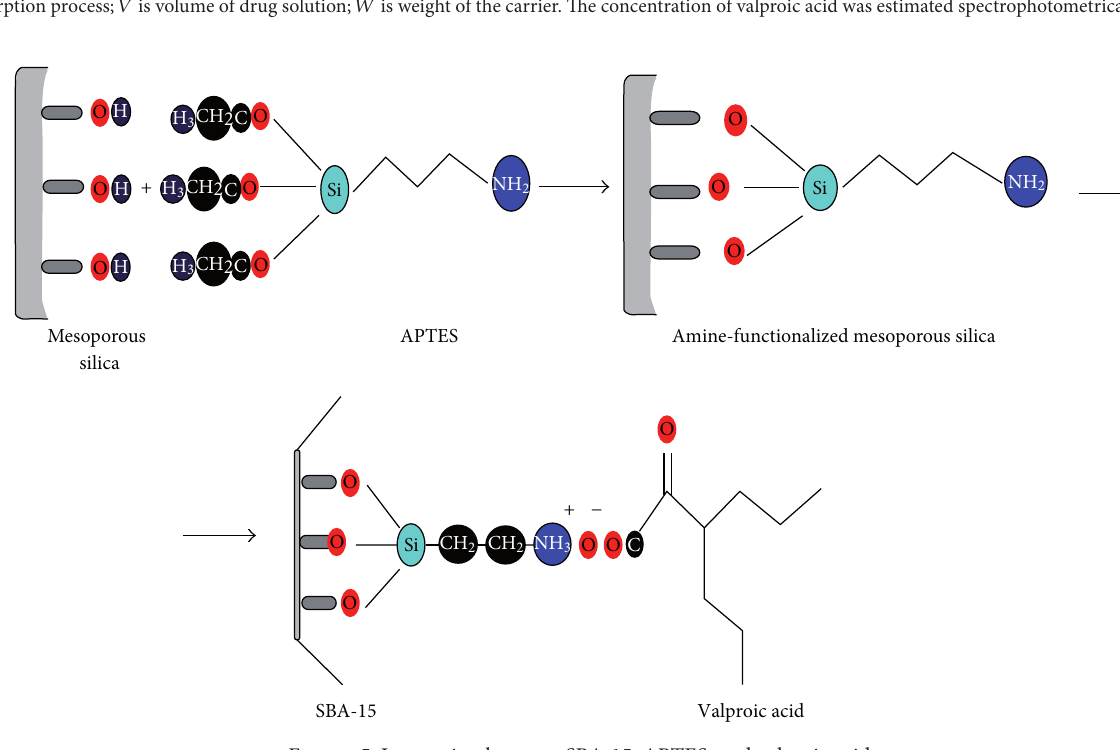
F 5: Interaction between SBA-15, APTES, and valproic